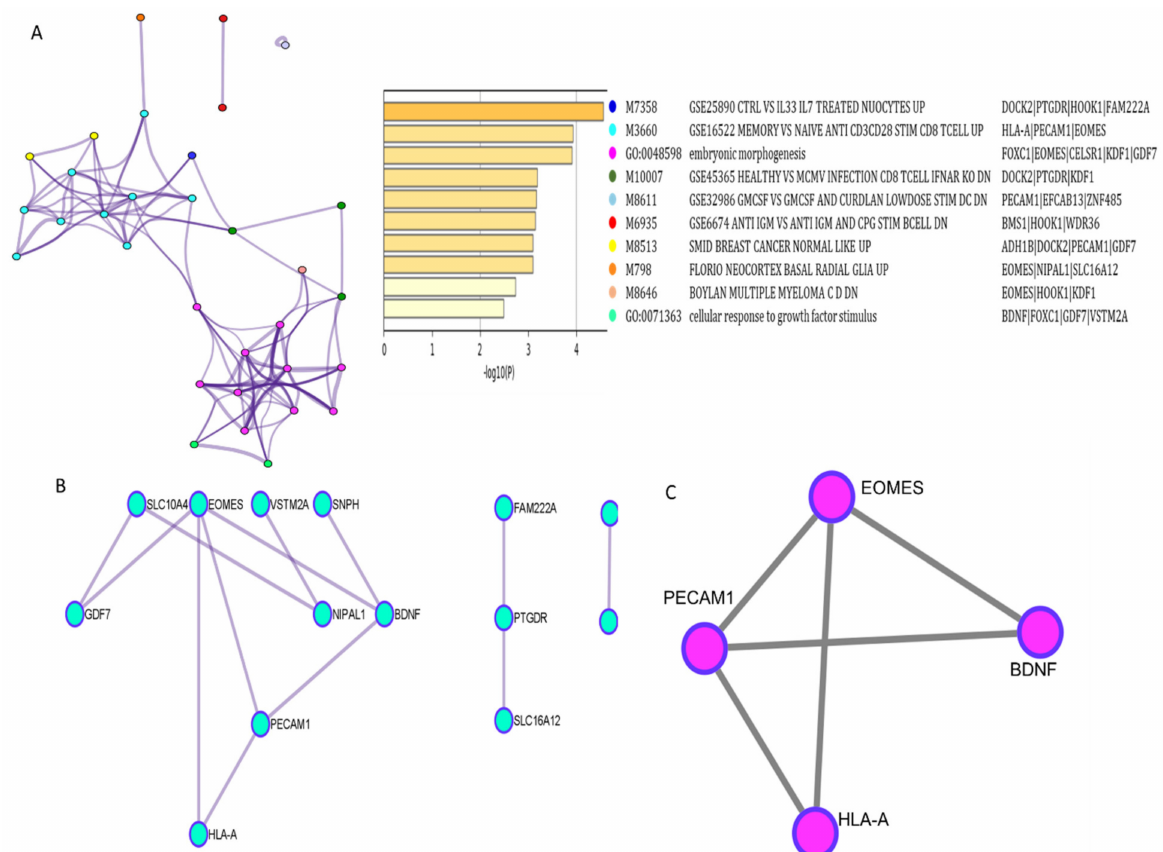
Figure 3. Functional enrichment and protein–protein interaction of 27 genes. ( A ) Functional Enrichment analysis of the 27 genes in promotor region obtained using Metascape represented as cluster with the heat map of the cluster based on P-value. ( B ) PPI network from Metascape analysis reproduced and edited in Cytoscape. ( C ) PPI network with highest MCODE scored from MCODE analysis in